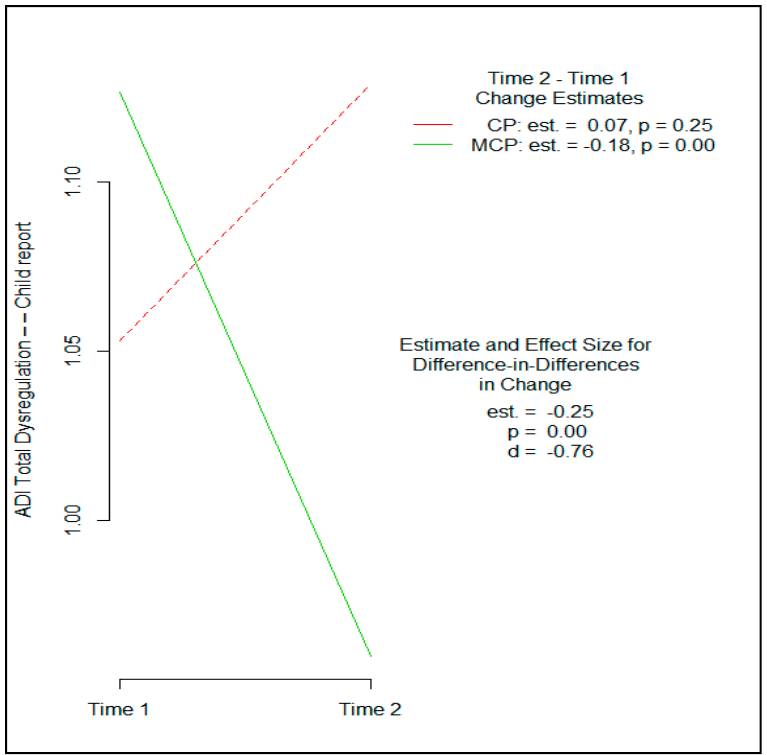
Figure 1. Comparative effects of Coping Power and Mindful Coping Power on children’s total dysregulation (affective, behavioral, cognitive) on the Abbreviated Dysregulation Inventory.